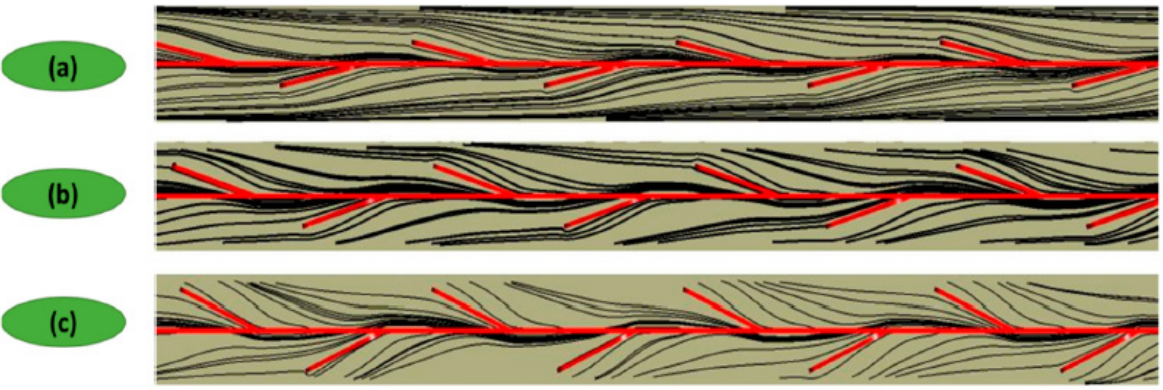
Figure 13. Streamlines along ( a ) 10°, ( b ) 15°, and ( c ) 20° PWT inserts.